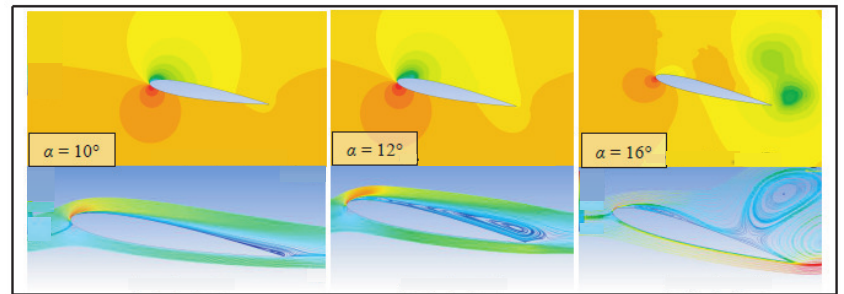
Figure 30. Pressure contours and streamlines at Re = 6.5 × 10 4